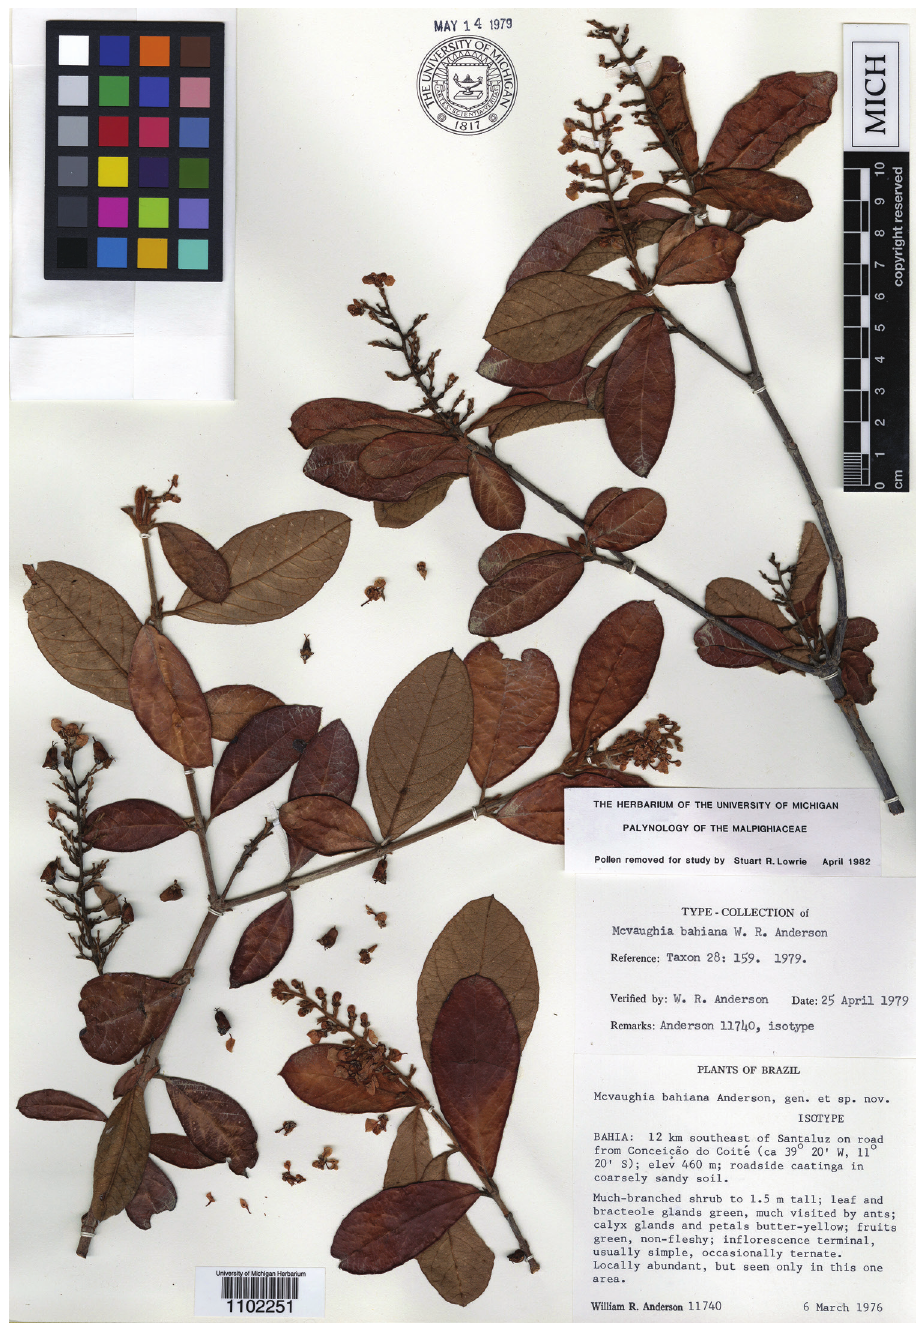
Figure 6. Photograph of the isotype of Mcvaughia bahiana